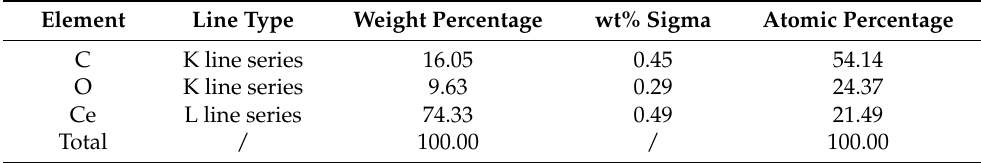
Figure 3. Micromorphological features of G3 ( a , b ) scanning electron microscopy (SEM) pattern; ( c ) energy dispersive X-ray spectroscopy (EDS) spectrum pattern. Table 1. Element line type and proportion.